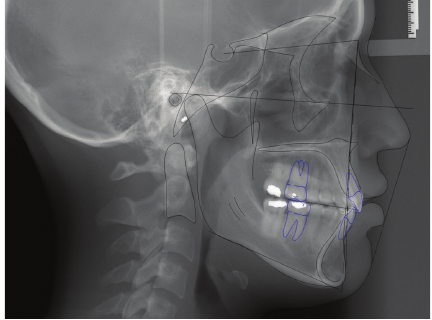
Figure 9: Final lateral cephalometric radiograph.